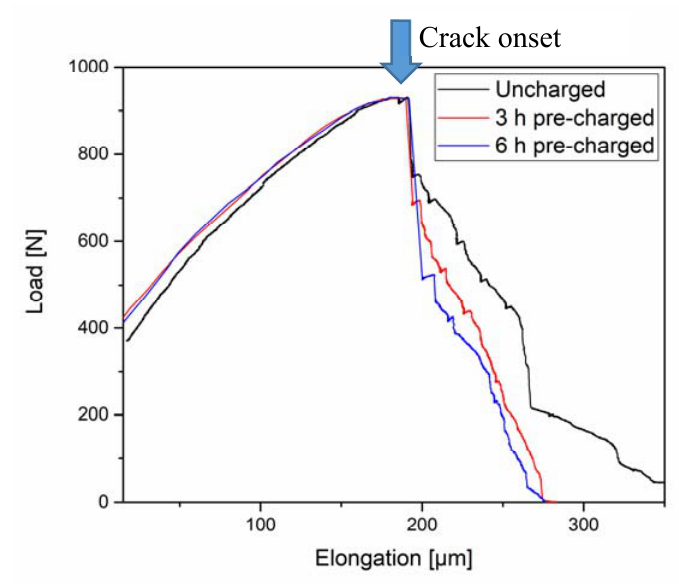
Figure 6. Load-elongation curves of three CP steel samples: uncharged, 3 h, and 6 h pre-charged.